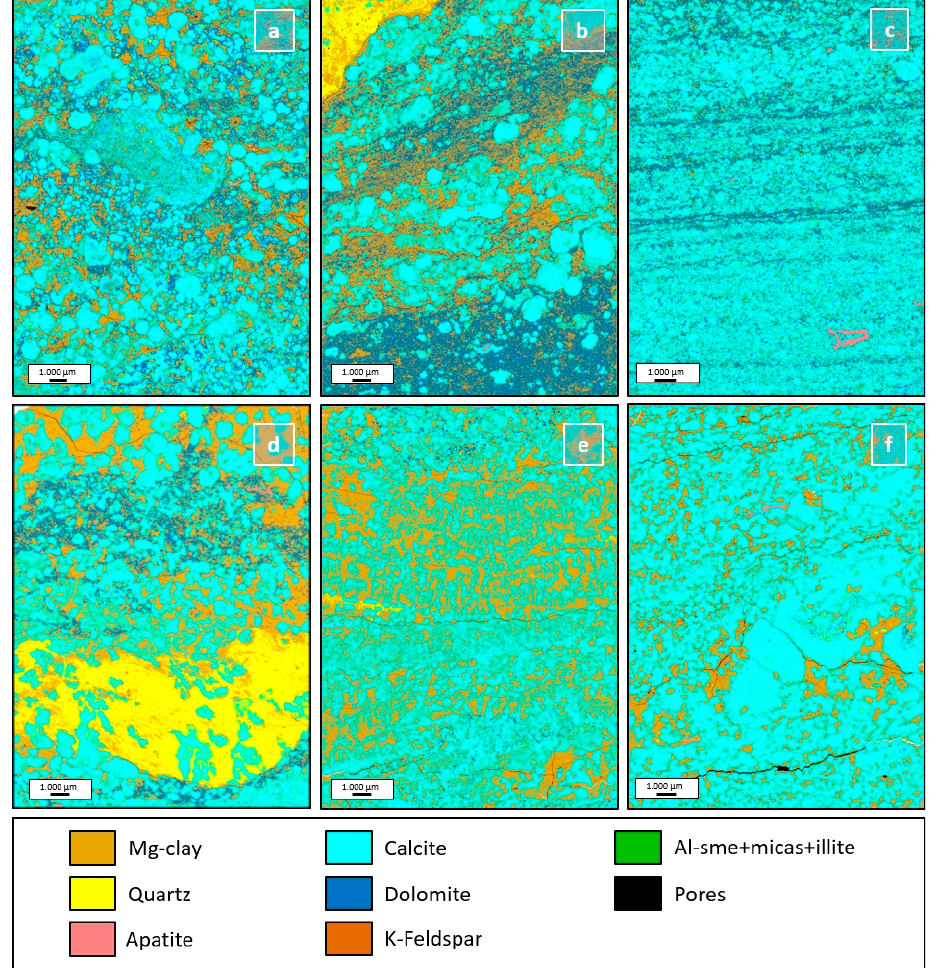
Figure 7. Mineralogical automated mapping analysis in thin sections from the sequence 2. ( a ) sample P1.38, positioned at the bottom of the sequence 2, representative of MF-4 and saponite-rich (assemblage C), showing Mg-clays replacement by dolomite and minor detrital grains. ( b ) sample P1.36 representative of MF-4 kerolite-rich (assemblage A) interval. Shows level of intense quartz replacement and interval where Mg-clays are mainly replaced by dolomite. ( c ) sample P1.34 is representative of a kerolite-rich (assemblage A) Mf-1 microfacies, showing Mg-clays mainly replaced by dolomite. ( d ) sample P1.32 from MF-4 stevensite-rich (assemblage C), showing one zone intensively replaced by quartz and a zone where the Mg-clays present replacement by dolomite. ( e ) sample P1.31 is representative of a kerolite-rich (assemblage A) from MF-4, locally replaced by quartz and dolomite. ( f ) sample P1.27 close to the top of the sequence. It shows kerolite-stevensite mixed layers (assemblage B) with minor replacement of Mg-clays by quartz and